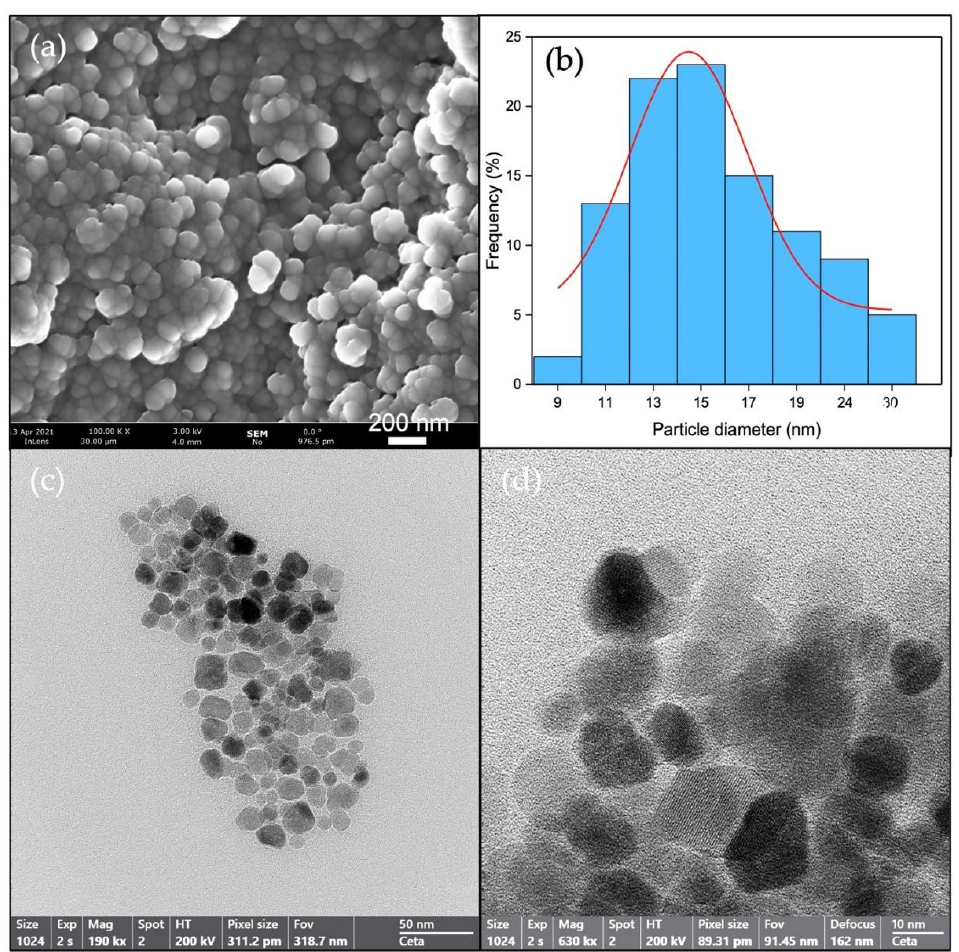
Figure 1. Morphology of Fe 3 O 4 nanoparticles: ( a ) SEM and ( c , d ) TEM micrographs; ( b ) curve distribution of particle size by TEM.